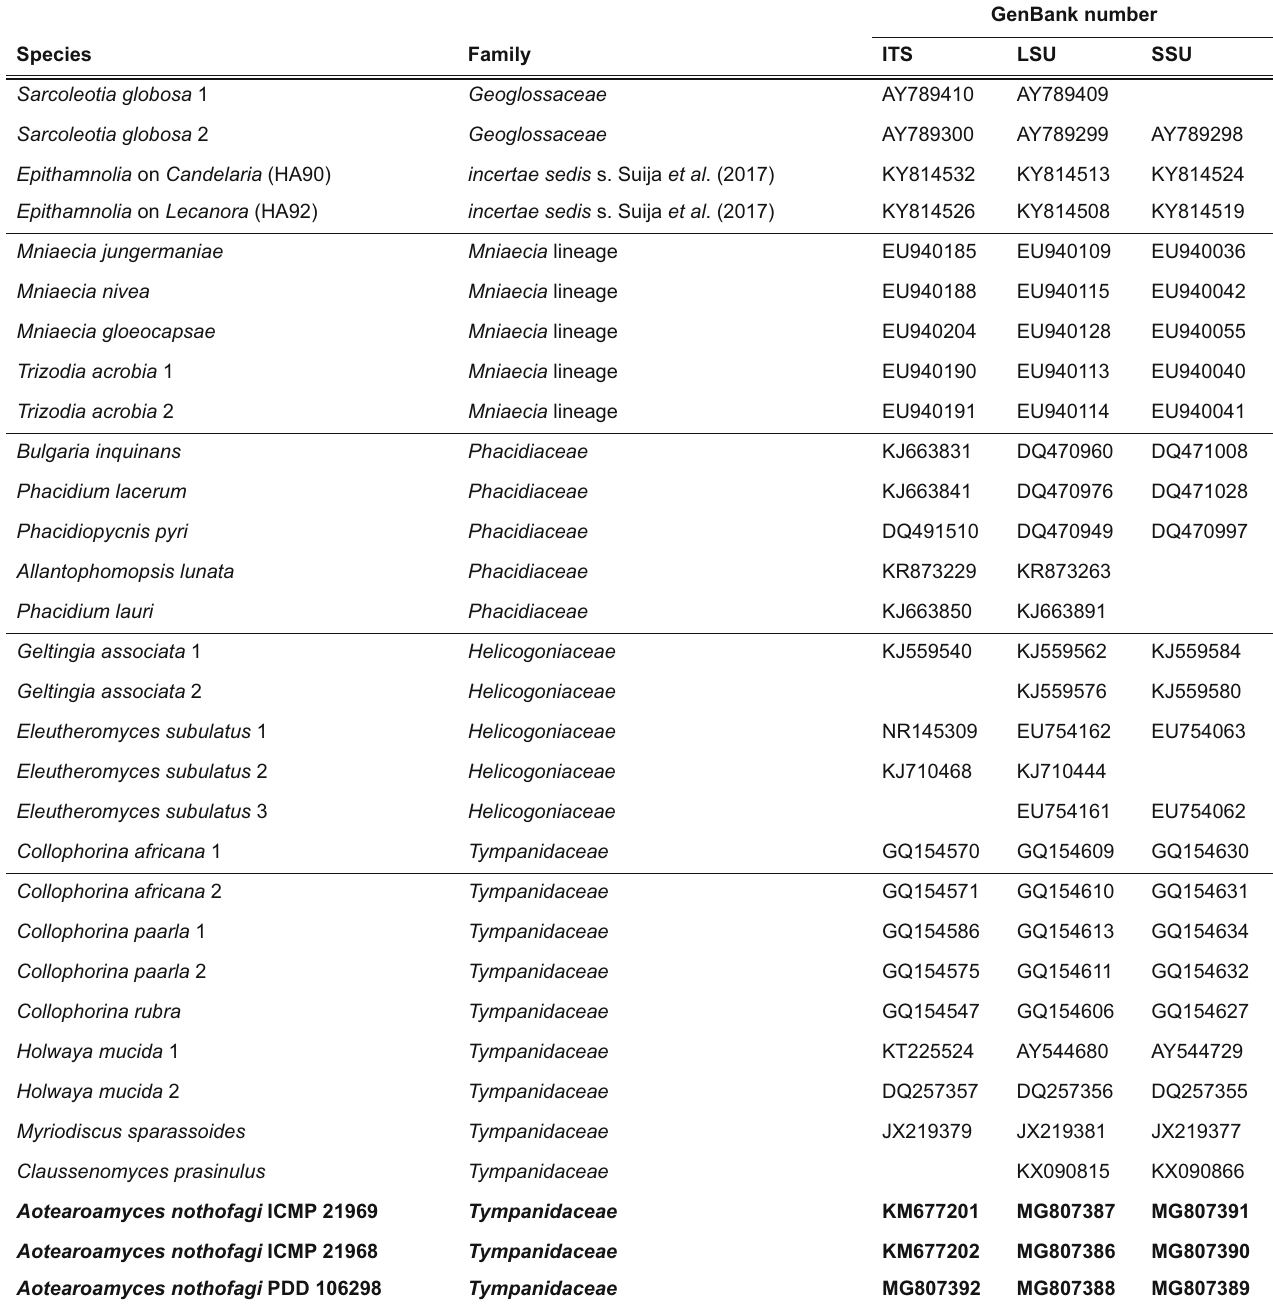
Table 1. (cid:2)=(cid:18)(cid:13)(cid:19)(cid:11)(cid:6)(cid:13)(cid:17)(cid:7)(cid:2)(cid:5)(cid:7)(cid:13)(cid:21)(cid:2)(cid:11)(cid:17)(cid:2)(cid:8)(cid:14)(cid:11)(cid:7)(cid:2)(cid:7)(cid:8)(cid:5)(cid:21)(cid:22)(cid:2)(cid:15)(cid:11)(cid:8)(cid:14)(cid:2)(cid:26)(cid:9)(cid:6)(cid:11)(cid:23)(cid:22)(cid:2)(cid:11)(cid:17)(cid:26)(cid:4)(cid:10)(cid:6)(cid:9)(cid:8)(cid:11)(cid:4)(cid:17)(cid:2)(cid:9)(cid:17)(cid:21)(cid:2)}(cid:13)(cid:17)!(cid:9)(cid:17)(cid:16)(cid:2)(cid:9)(cid:19)(cid:19)(cid:13)(cid:7)(cid:7)(cid:11)(cid:4)(cid:17)(cid:2)(cid:17)(cid:5)(cid:6)(cid:12)(cid:13)(cid:10)(cid:7)(cid:28)(cid:2)=(cid:13)*(cid:5)(cid:13)(cid:17)(cid:19)(cid:13)(cid:7)(cid:2)(cid:4)(cid:26)(cid:2)(cid:8)(cid:14)(cid:13)(cid:2)(cid:17)(cid:13)(cid:15)(cid:2)(cid:7)(cid:18)(cid:13)(cid:19)(cid:11)(cid:13)(cid:7)(cid:2)(cid:9)(cid:10)(cid:13)(cid:2)(cid:11)(cid:17)(cid:21)(cid:11)(cid:19)(cid:9)(cid:8)(cid:13)(cid:21)(cid:2) in bold